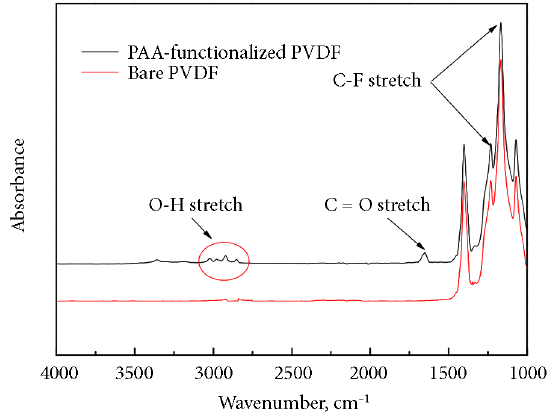
Figure 2. FTIR spectrum for bare and PAA-functionalized PVDF films